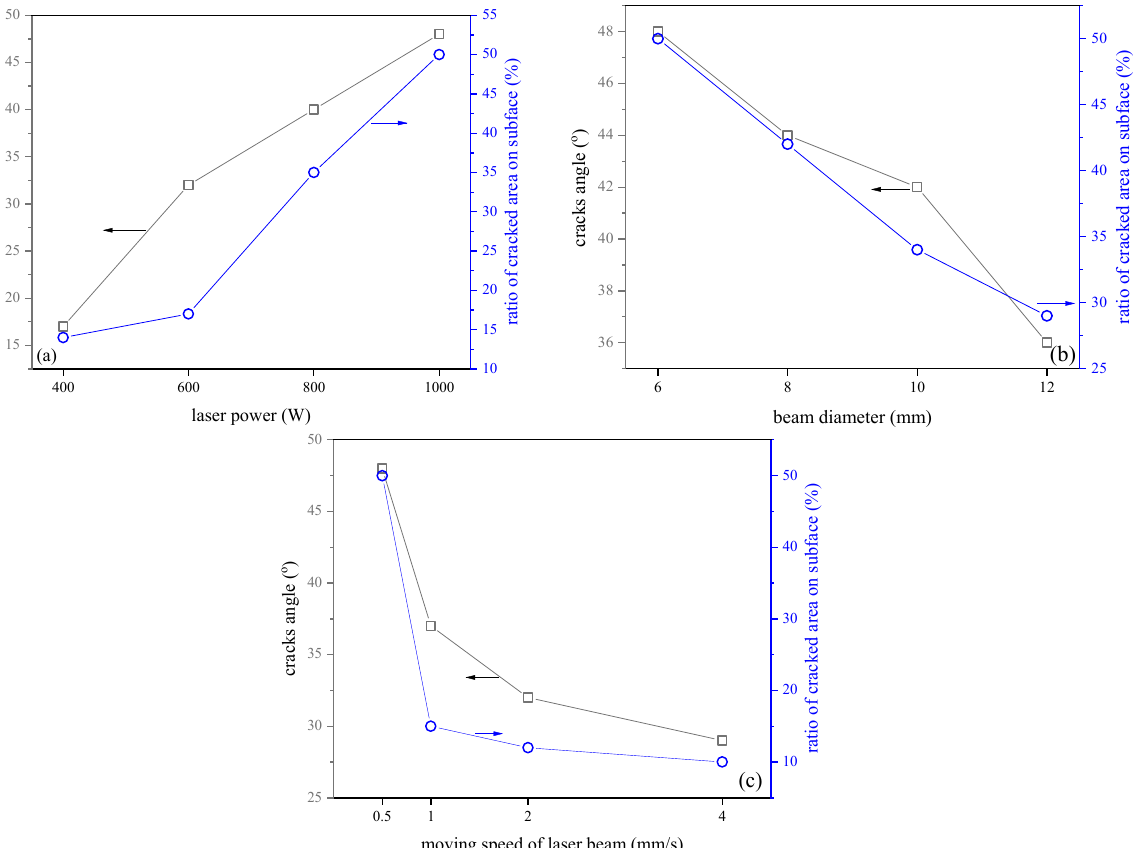
Figure 9. Cracks of irradiated granite on the bottom surface.